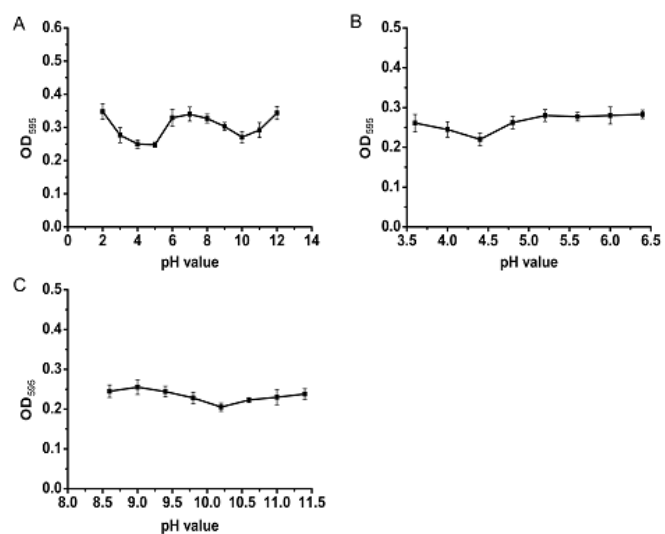
Figure 2. Absorbance of supernatants with different pH after reaction with Coomassie Brilliant Blue. ( A ) pH 2–12; ( B ) pH 3.6–6.4; ( C ) pH 8.6–11.4.